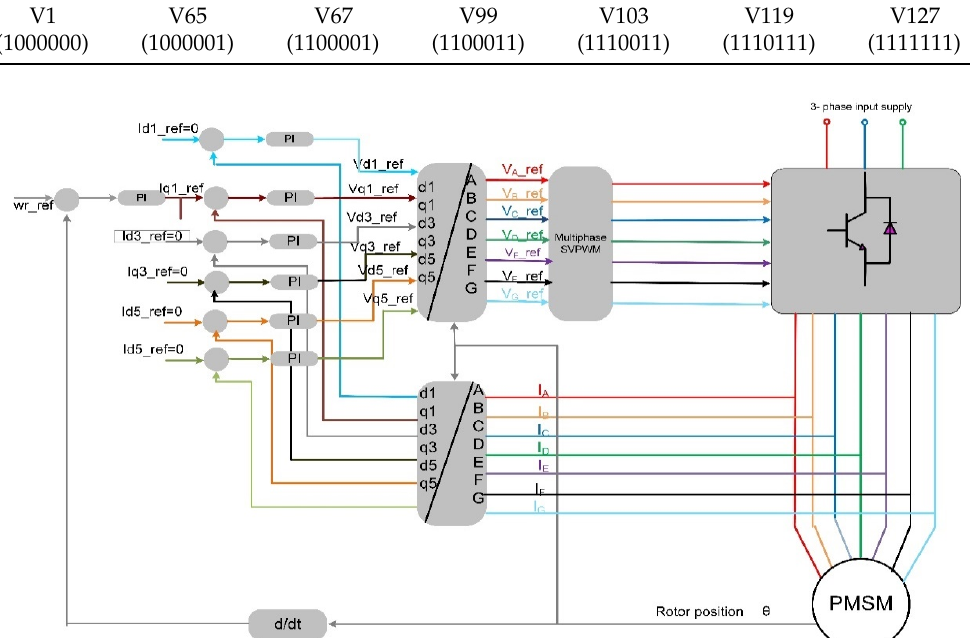
Figure 5. Vector control topology using NSV-SVPWM for the seven -phase drive.